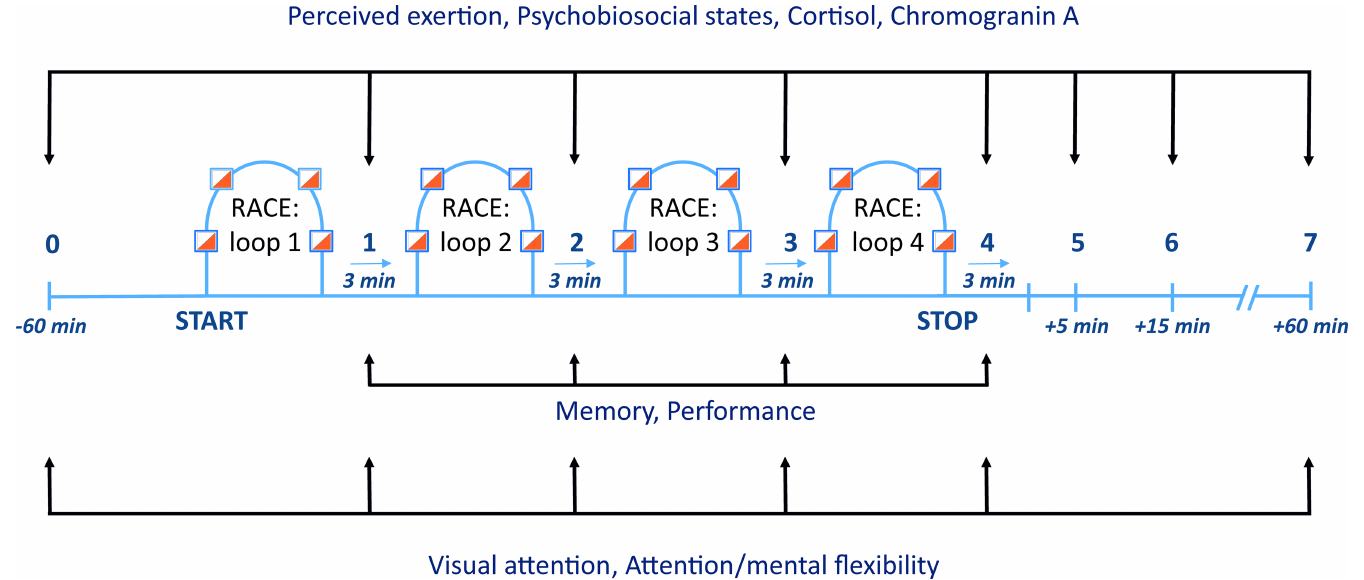
Fig 1. Timeline of assessment schedule across the